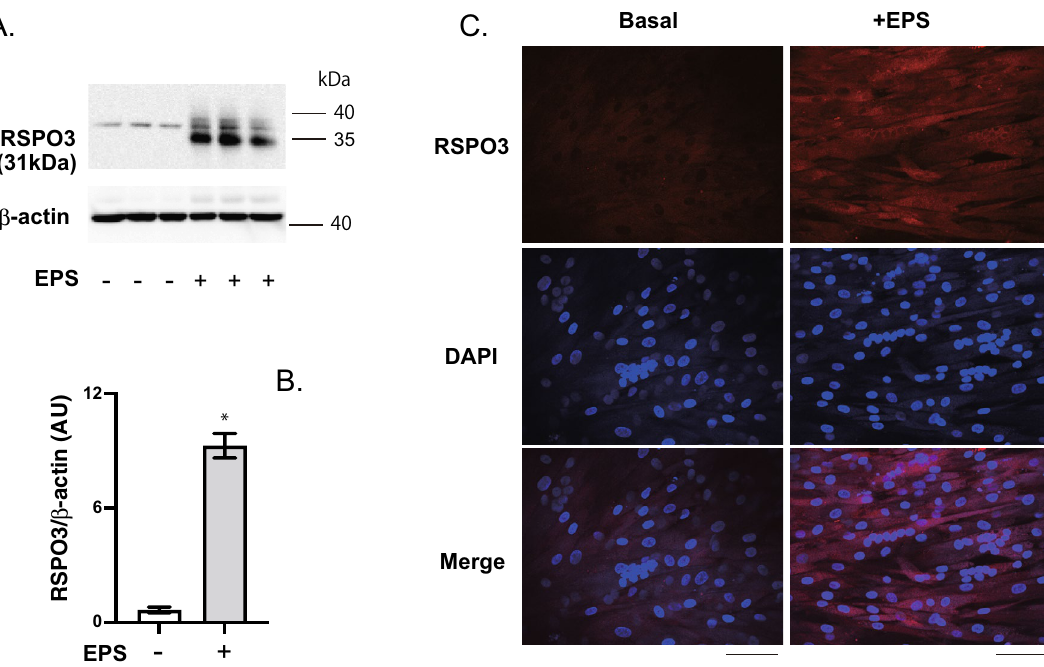
Figure 2. Western blotting and immunofluorescent staining analyses of human R-spondin 3 (RSPO3) protein in human myotubes. ( A ) Whole cell lysates of the differentiated human myotubes (day8) with or without 24 h of EPS in total (1 Hz, 4-ms, 20 V/25 mm) were subjected to Western blot analysis using anti-RSPO3 and anti-β-actin antibodies. Three independent experiments were performed; representative results are shown. ( B ) Results from ( A ), RSPO3 protein amounts in response to EPS, were subjected to densitometric analysis of all bands broadly detected around 35 ~ 40 kDa for quantification ( n = 3). Data normalized using β-actin protein amounts. ( C ) Differentiated human myotubes on the Cell-Discs with and without 24 h in total of EPS treatment were fixed with paraformaldehyde-PBS and then subjected to immunofluorescent staining using anti-RSPO3 antibody ( red ). DAPI was used for nuclear staining ( blue ). Scale bar = 100 µm. Three independent experiments were performed, and representative images are